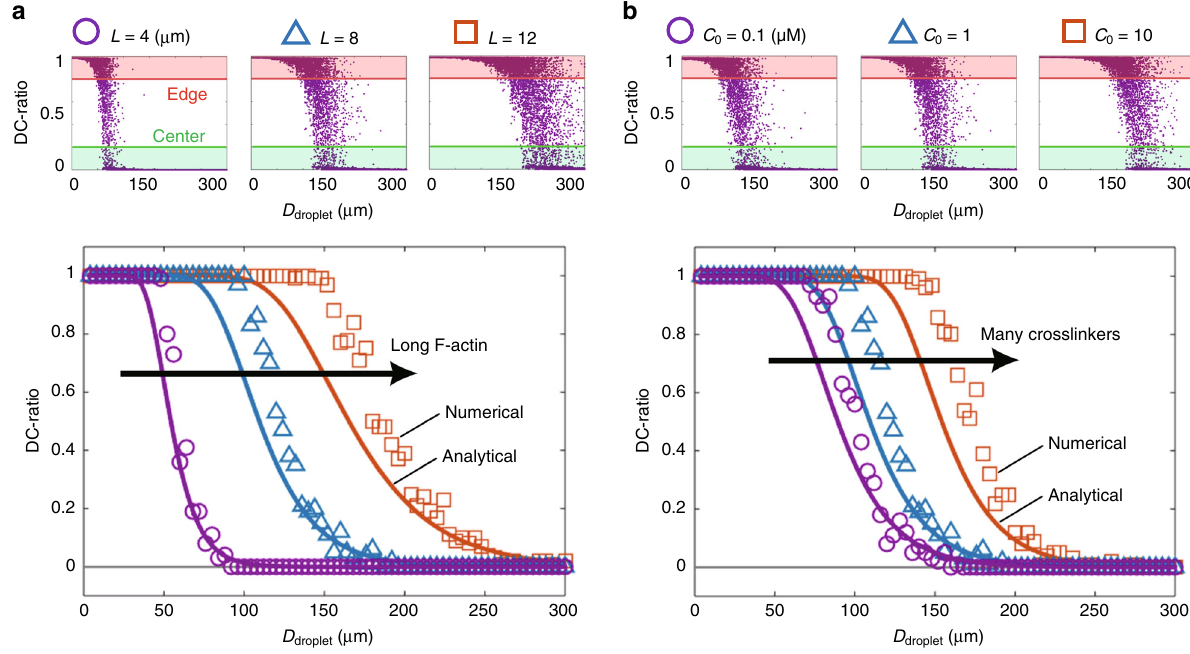
Fig. 7 Numerical simulations and the analytical solution of the tug-of-war model reproduce the two-state cluster positioning. Both numerical simulations and the analytical solution Eq. (2) of the tug-of-war model (Fig. 6) reproduce the results of perturbation experiments (Fig. 5). (Top) In R T 0 ½ d ð t Þ = R (cid:3) d t ( T = 1800 s) for each droplet was determined to statistically evaluate percolation numerical simulations, the time averaged DC-ratio ð 1 = T 0 Þ 0 0 dynamics, displayed as purple dots. (Bottom) Thereafter, the edge probability was determined from the DC-ratio, where a DC-ratio > 0.8 and <0.2 was classi fi ed as the “ edge ” and the “ center ” , respectively. a F-actin length L was changed with the fi xed crosslinker concentration ( C 0 = 1 μ M). Purple circles, blue triangles, and orange squares represent numerical simulations with L = 4 μ m, L = 8 μ m, and L = 12 μ m, respectively. Solid curves are the corresponding analytical solutions. b Crosslinker concentration C 0 was changed with the fi xed F-actin length ( L = 8 μ m). Purple circles, blue triangles, and orange squares represent numerical simulations with C 0 = 0.1 μ M, C 0 = 1 μ M, and C 0 = 10 μ M, respectively. Solid curves are the corresponding analytical solutions. We de fi ned different DC-ratio thresholds for the edge region from the experiments, because numerical simulations were performed for clusters without their fi nite volume, in which the centroid of the clusters is possible to reach the droplet boundary. For details, see Supplementary Note